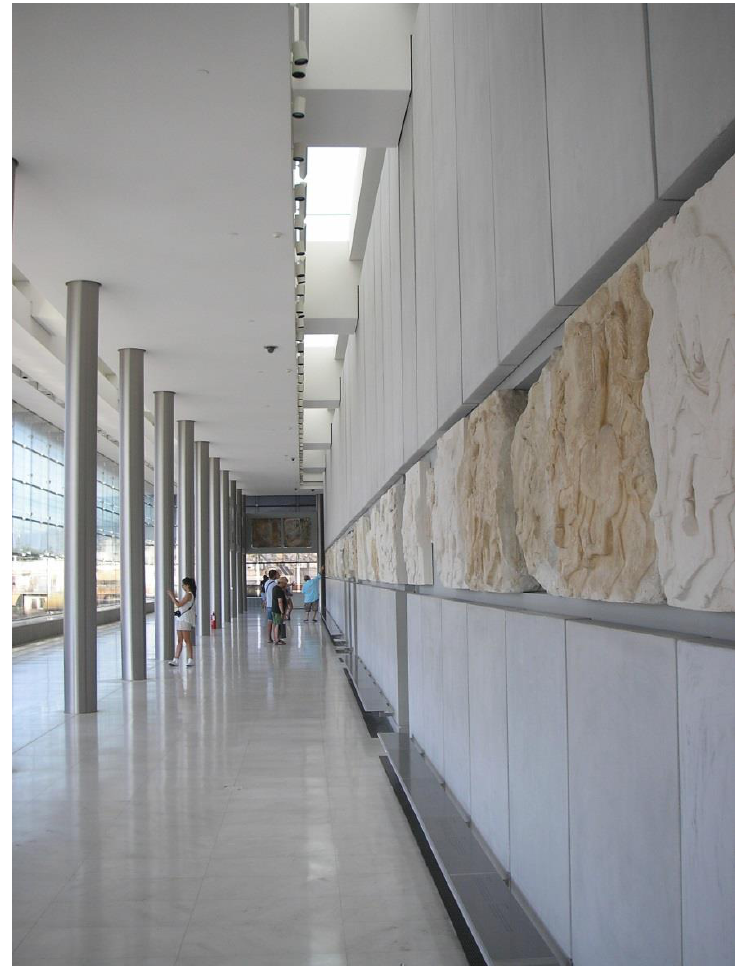
Figure 5. The frieze as displayed in the Parthenon Gallery of the New Acropolis Museum. Illuminated by natural light provided by the main windows and slit skylights above, the honey-coloured original marbles contrast sharply with the white plaster casts from those sculptures currently in the British Museum. Photograph: J. Beresford. Reproduced with the permission of the Acropolis